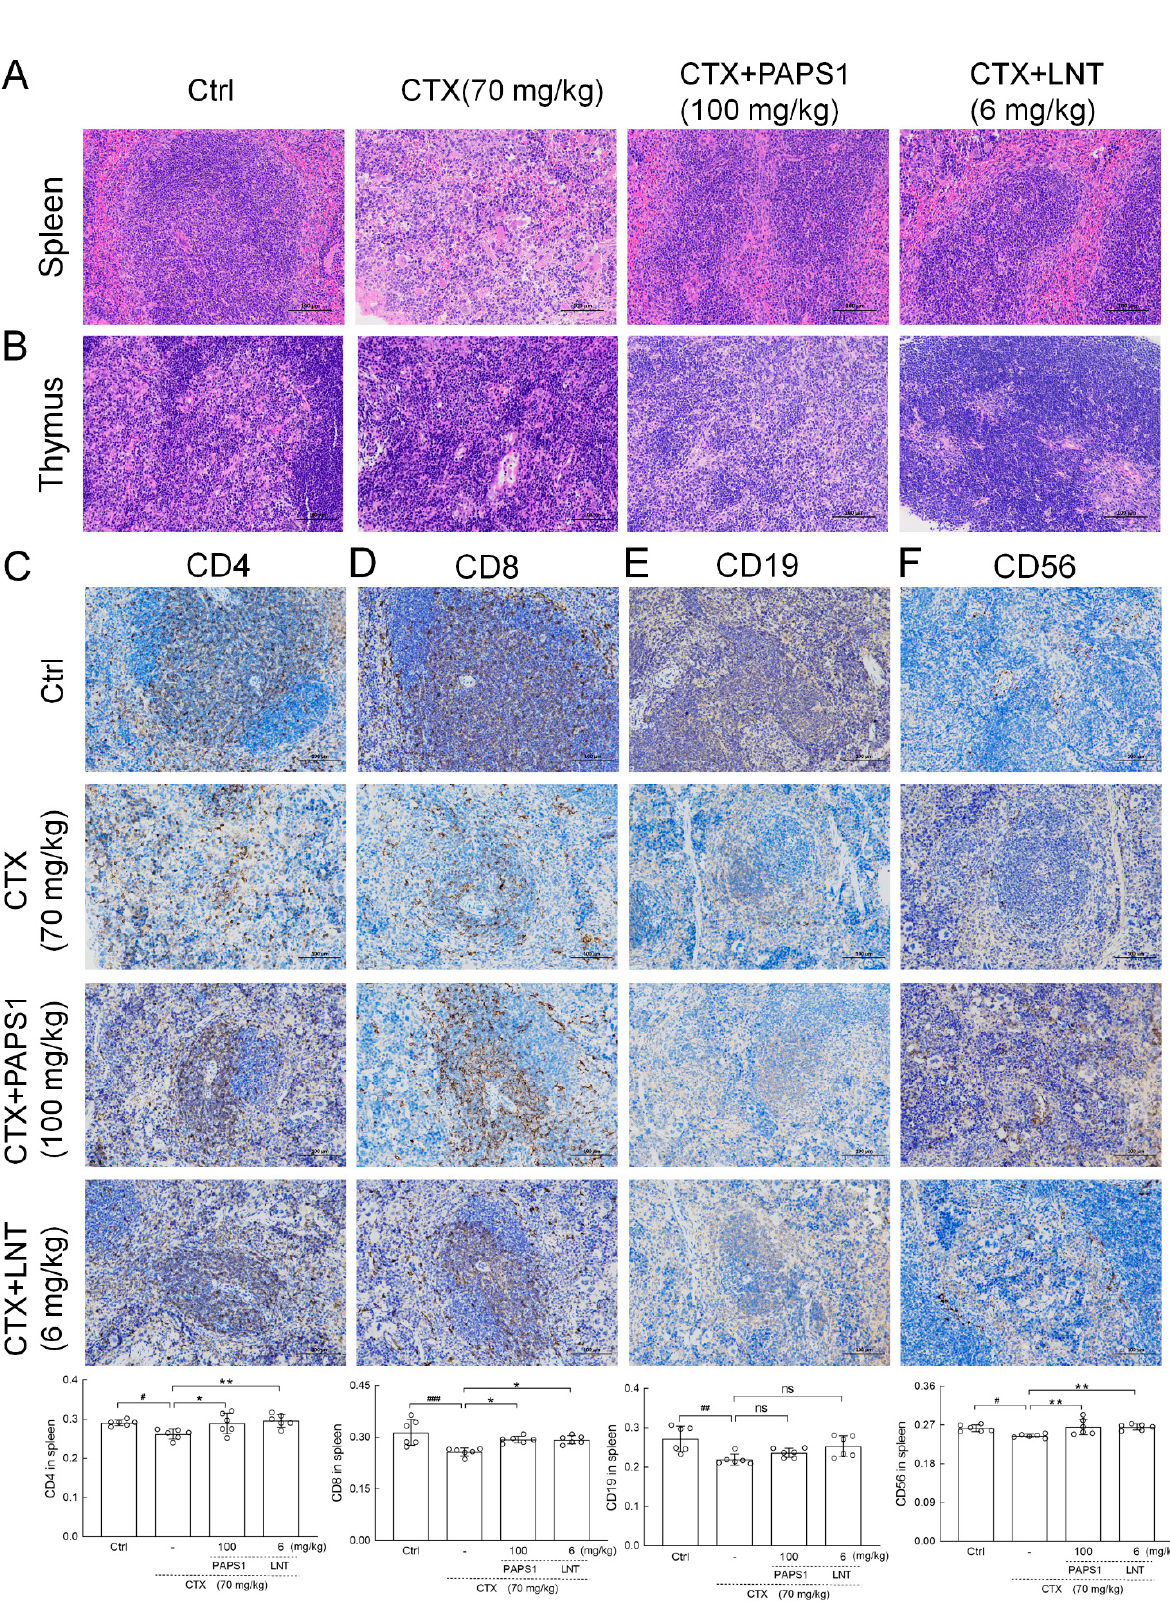
Figure 3. PAPS1 improved the histopathological damage caused by CTX in the spleen and thymus, and it increased the immunophenotype expression of immune cells in the spleen. Histopathological observation of the ( A ) spleen and ( B ) thymus (magnification: 200×, scale bar: 100 μ m). Immunohistochemical staining of ( C ) CD4, ( D ) CD8, ( E ) CD19 and ( F ) CD56 in the spleens of mice (magnification: 200×, scale bar: 100 μ m). The average optical density is represented on the y-axis. Data are